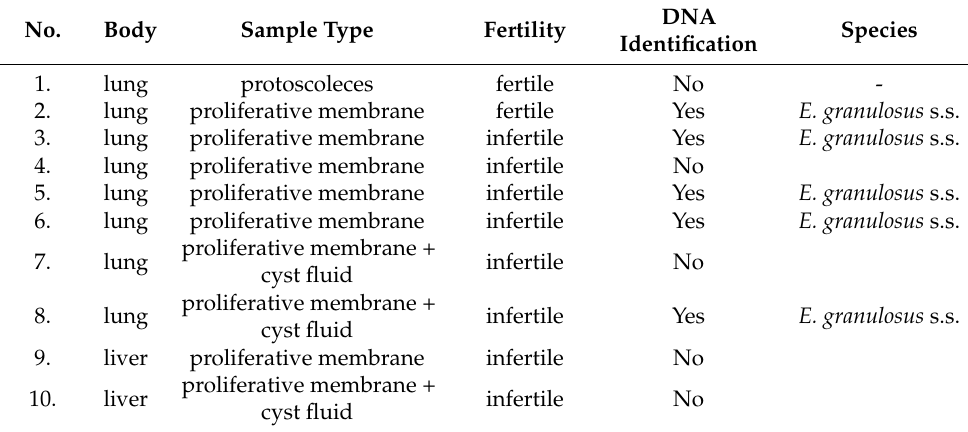
Table 4. PCR analyzed